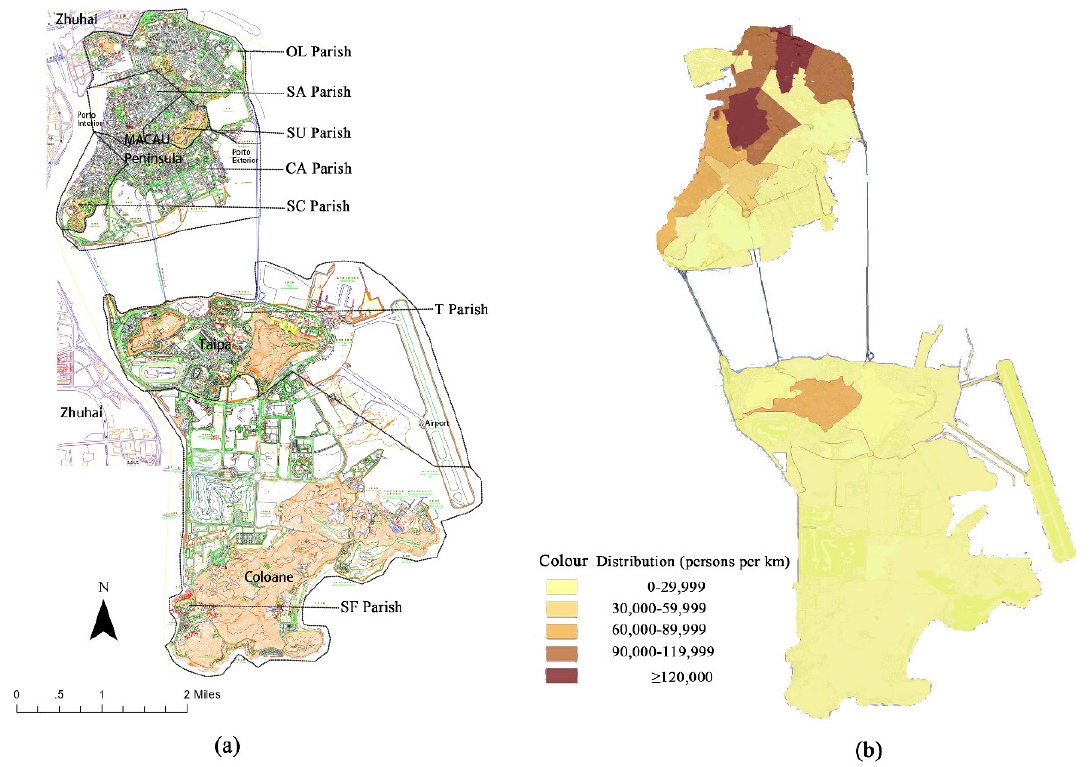
Figure 2. Macau Special Administrative Region (SAR). ( a ) Parish in Macau; ( b ) Population density [34,35].